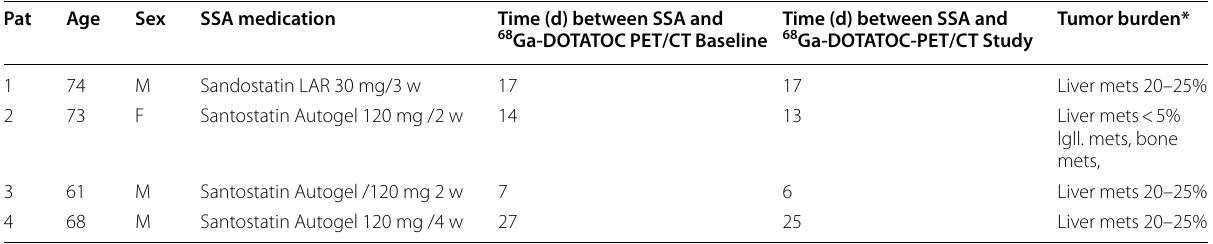
Table 1 Basic patient characteristics, SSA medication, dosing interval and interval between SSA administration and 68 Ga‑DOTATOC PET/CT examinations Pat: patient, M: male, F: female, w: weeks, d: days, mets: